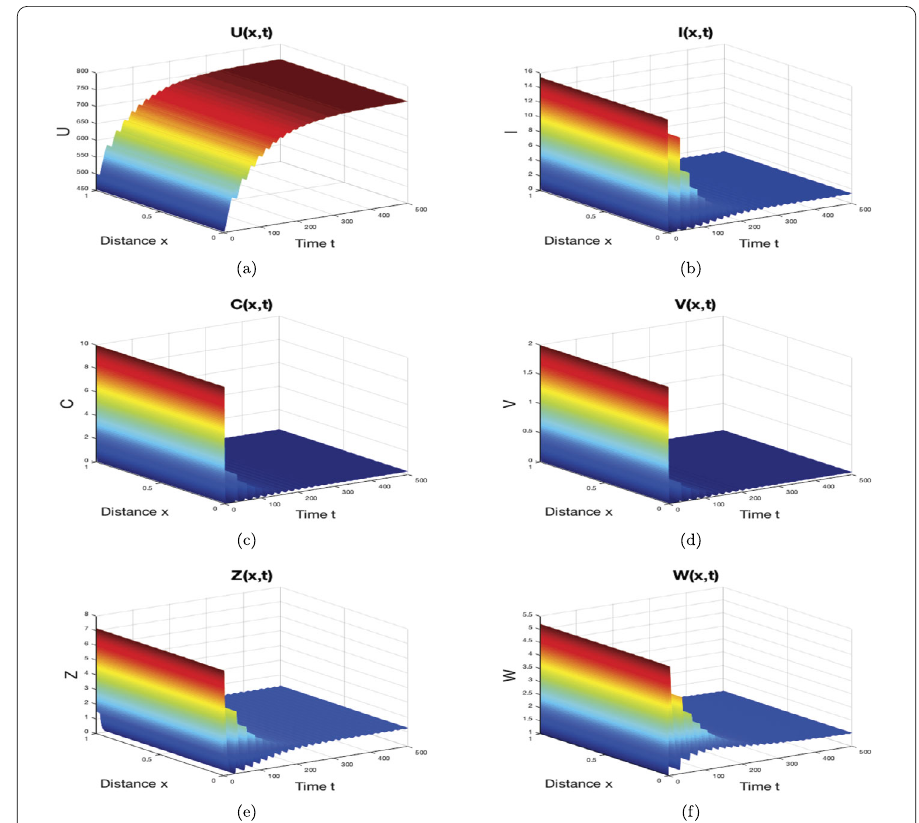
Figure 5 The numerical simulations of system (44)–(46) when R 3 > 1 and R 1 > R 3 > 1. The equilibrium with two immune responses M 4 is globally asymptotically stable. The sub-figures show the spatiotemporal behaviors of ( a ) uninfected hepatocytes, ( b ) infected hepatocytes, ( c ) capsids, ( d ) viruses, ( e ) CTLs, and ( f ) B cells